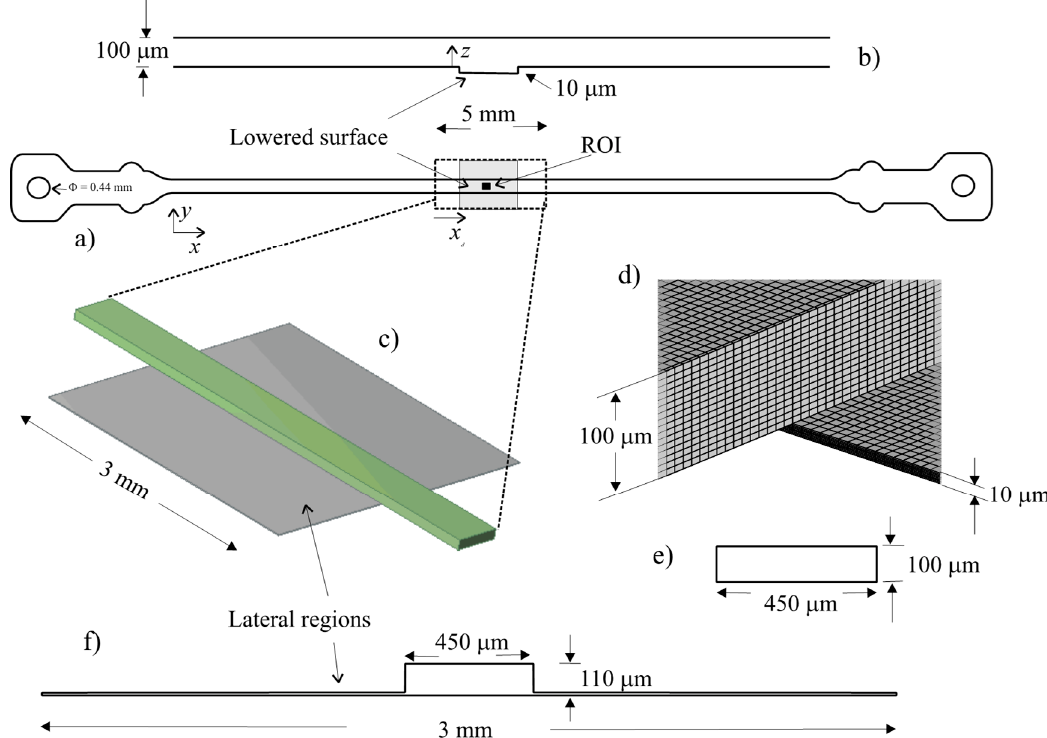
Figure 2. Microchannel representation and mesh details: ( a ) Microchannel, showing the lowered surface in grey, the region of interest in black and domain limits; ( b ) Profile representing the level of the upper and lower surfaces of the channel; ( c ) 3D representation of the numerical domain; ( d ) Lowered surface detail; ( e ) Microchannel cross-section outside the lowered region; ( f ) Cross-section available to the flow in the lowered surface region.